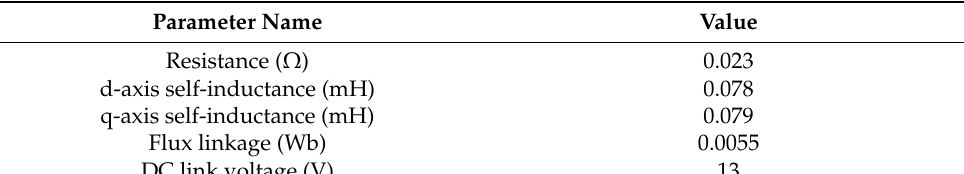
Table 1. The design parameters of the DW-PMSM.